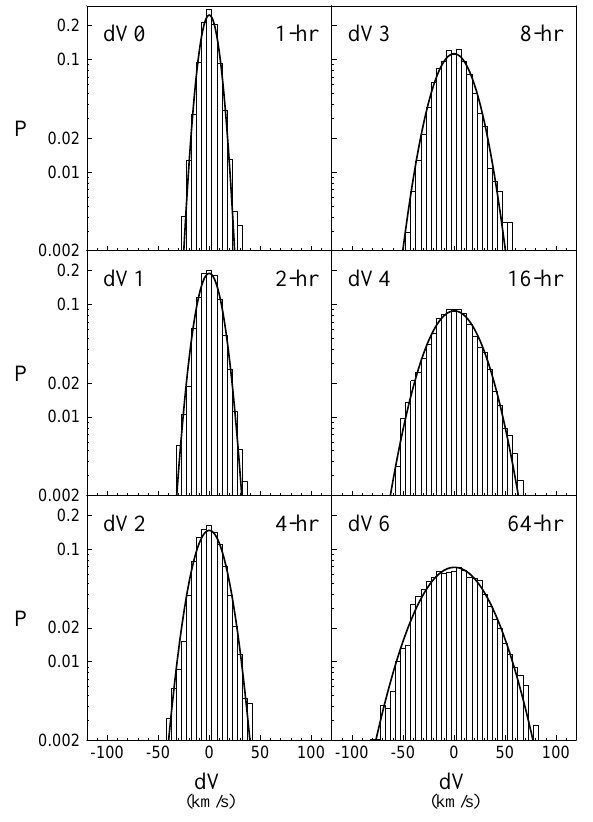
Fig. 5. The occurrence frequency P (in a logarithmic scale) of the velocity differences dV 0, dV 1, dV 2, dV 3, dV 4, and dV 6 is shown by histograms in the different panels. The solid curves correspond to Gaussian distribution functions as computed from the observed values of mean and standard deviation.